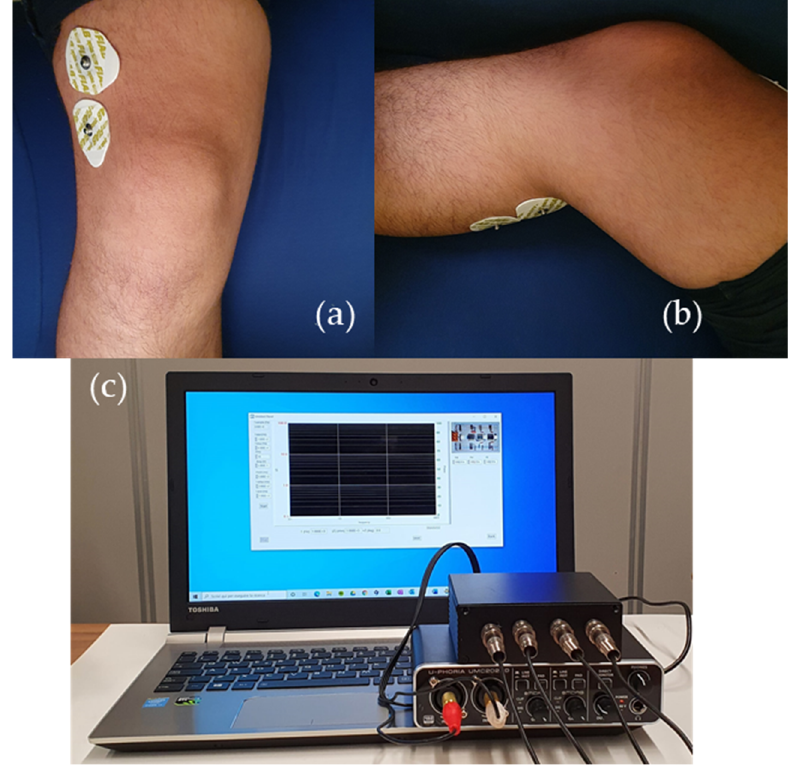
Figure 9. Electrodes arrangement ( a ) and ( b ) and developed measurement system ( c ).